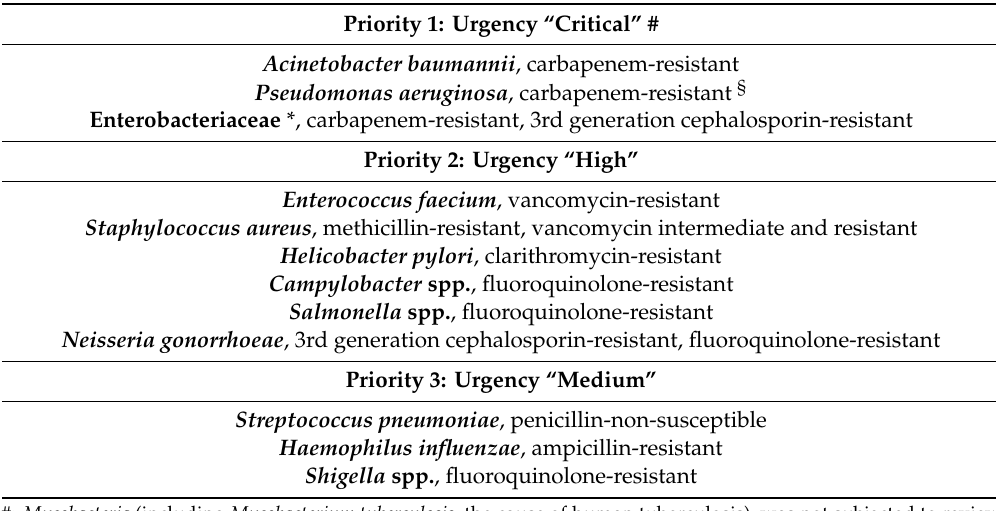
Table 1. WHO priority pathogens list for research and development (R&D) of new antibiotics [5]. Priority 1: Urgency “Critical”